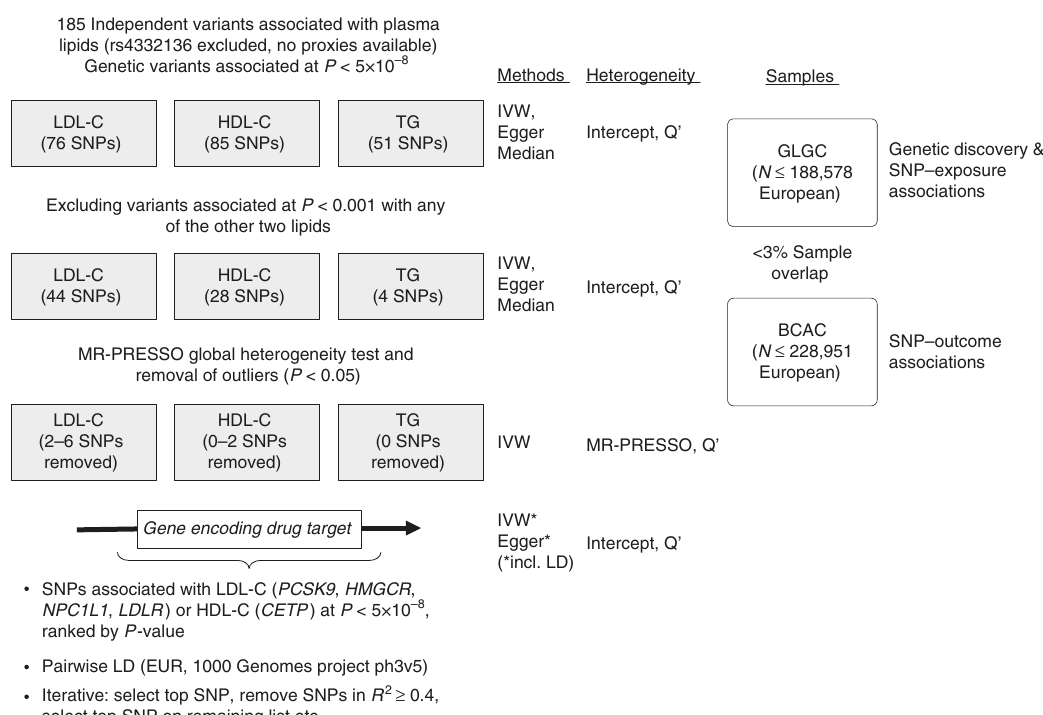
Fig. 1 Study overview. BCAC: Breast Cancer Association Consortium, Egger MR Egger method, EUR European reference sample, GLGC Global Lipids Genetics Consortium, HDL-C high-density lipoprotein-cholesterol, Intercept Egger regression intercept term, IVW inverse variance-weighted method, LD linkage disequilibrium, LDL-C low-density lipoprotein-cholesterol, MR-PRESSO MR pleiotropy residual sum and outlier, Q ′ modi fi ed 2nd order weight heterogeneity test, SNP single nucleotide polymorphisms, TG